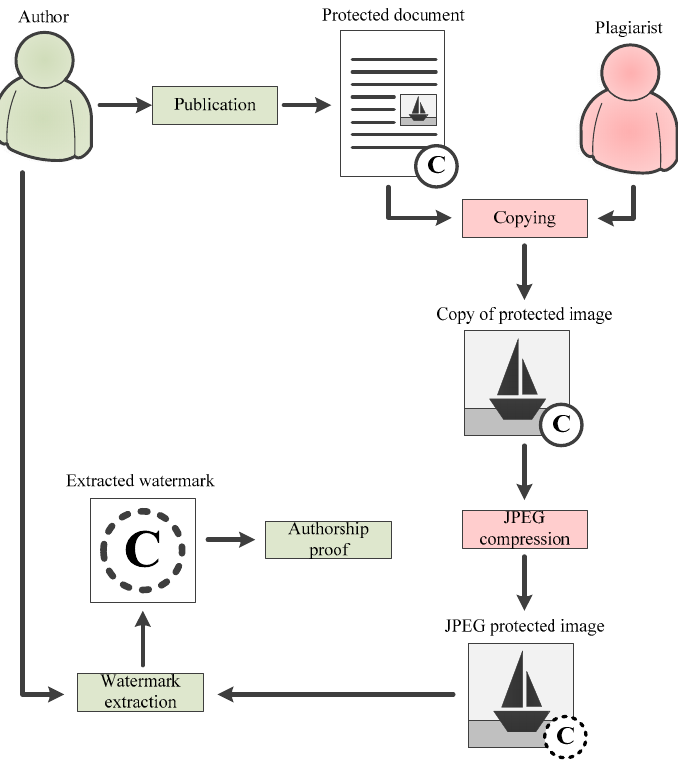
Figure 6. Authorship proof scenario when copying images only.